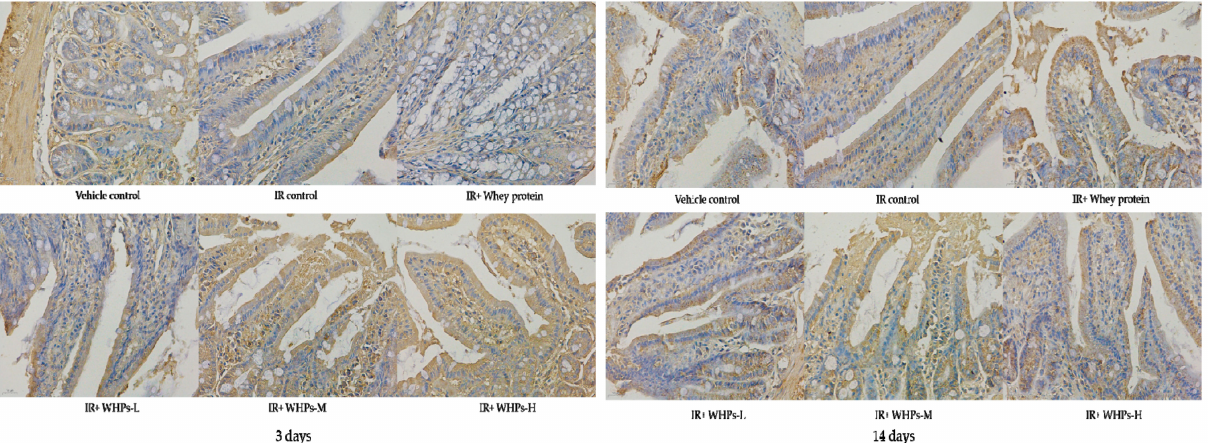
Figure 7. Effect of WHPs on the expression of occludin proteins in mice (400 × ). IR, irradiated mice; IR+WHPs-L, irradiated mice+low-dose whey hydrolysate peptides; IR+WHPs-M, irradiated mice+medium-dose whey hydrolysate peptides; IR+WHPs-H, irradiated mice+high-dose whey hydrolysate peptides.